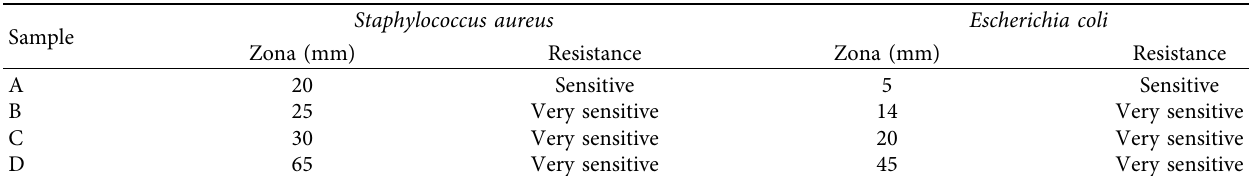
Figure 3: Antibacterial testing results of of hyaluronic acid (HA): chitosan hydrogel with varying composition HA: chitosan sample Table 1: Antibacterial testing results.